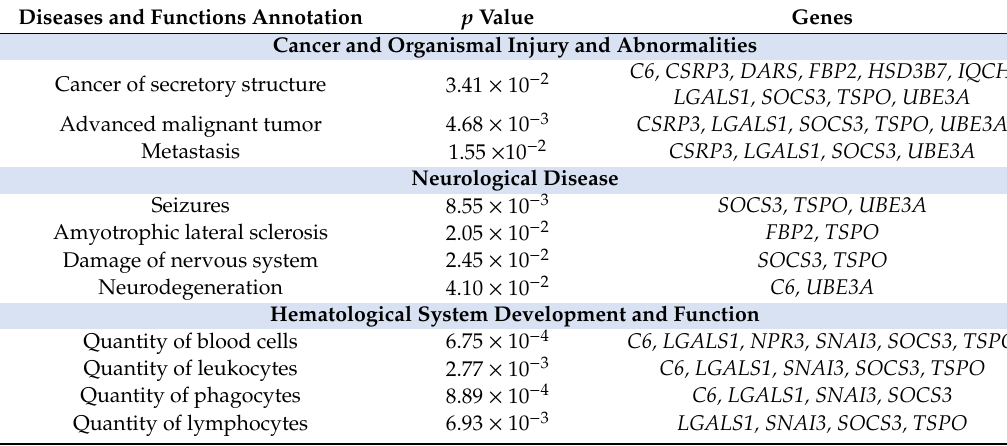
Table 2. Diseases and functions from IPA of genes with the most significant changes ( p value) in gene expression in control versus propoxur-exposed groups, including the genes in the